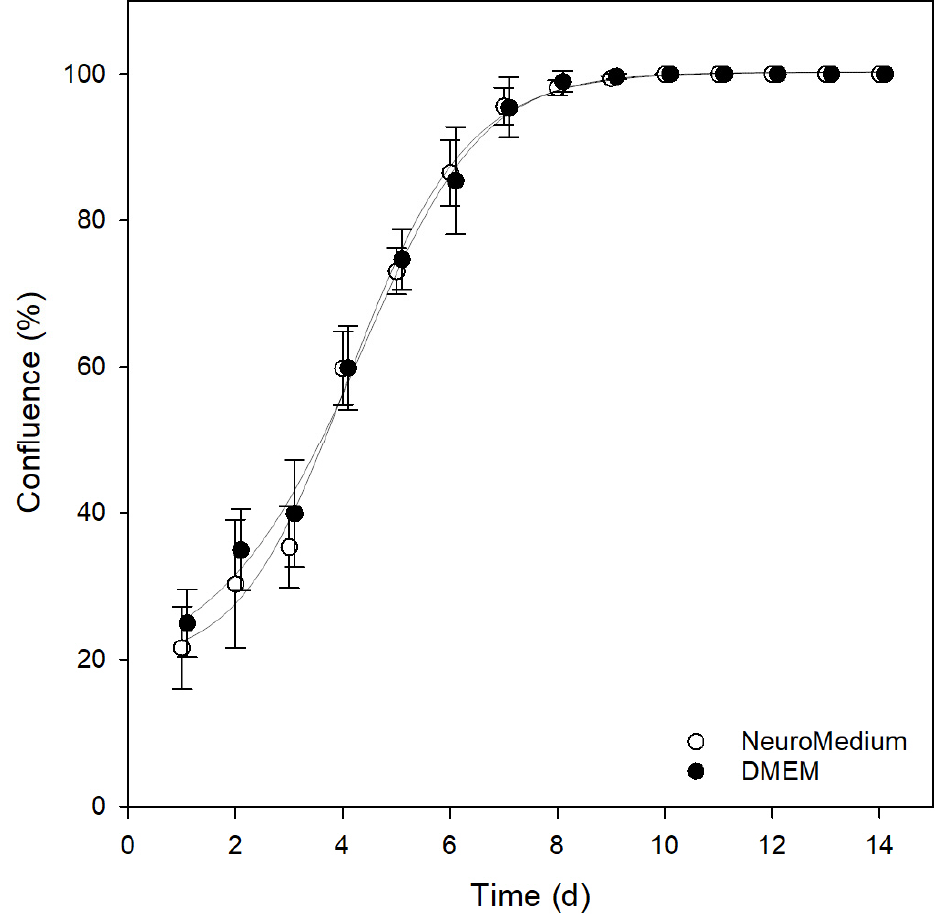
Figure 5. Comparison of SH-SY5Y confluence in the two most commonly used cultivating media during 14 days of cultivation based on the confluence determined by the bright field live-cell imaging. (Regression coefficient for NeuroMedium: r 2 = 0.9967; for DMEM: r 2 = 0.9974.) The viability of the cells can only be determined indirectly. Membrane integrity as viability marker was determined by the permeability for the dye trypan blue [36,37]. A high cell viability is essential to perform reproducible experiments. Values concerning the proliferation rate of SH-SY5Y cells were determined using a Luna automated cell counter (Logos Biosystems, Korea). For each measurement, the cells were trypsinized, dissociated, and resuspended in NeuroMedium as described above. Then a solution containing 0.4% of the dye trypan blue was added to the cell suspension in a 1:1 ratio. This allowed dead cells to be distinguished from living cells by their respective membrane integrity as measured by the permeability of cells towards the trypan blue dye. The stained cells were counted automatically by the cell counting system, and the data were statistically analyzed (Figure 4). For each viability and cell count measurement, ~1.3 × 10 3 cells were analyzed. The fraction of cells found to be single cells during cell counting and seeding was >98% for all experiments. The remaining 2% that occurred as cell clumps with two or more cells were not considered for further